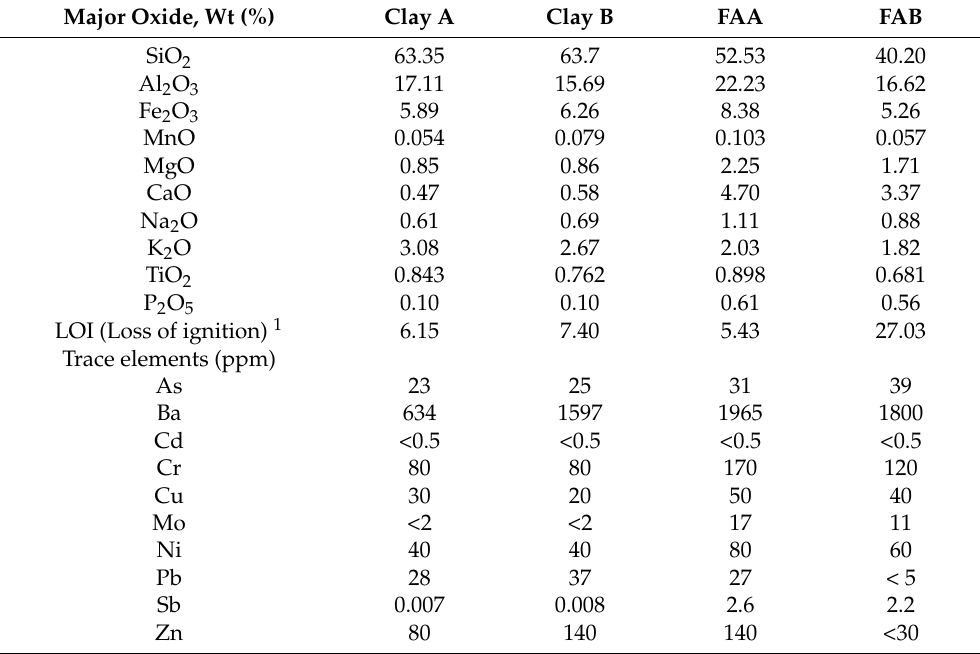
Table 2. Chemical composition of raw materials. Major Oxide, Wt